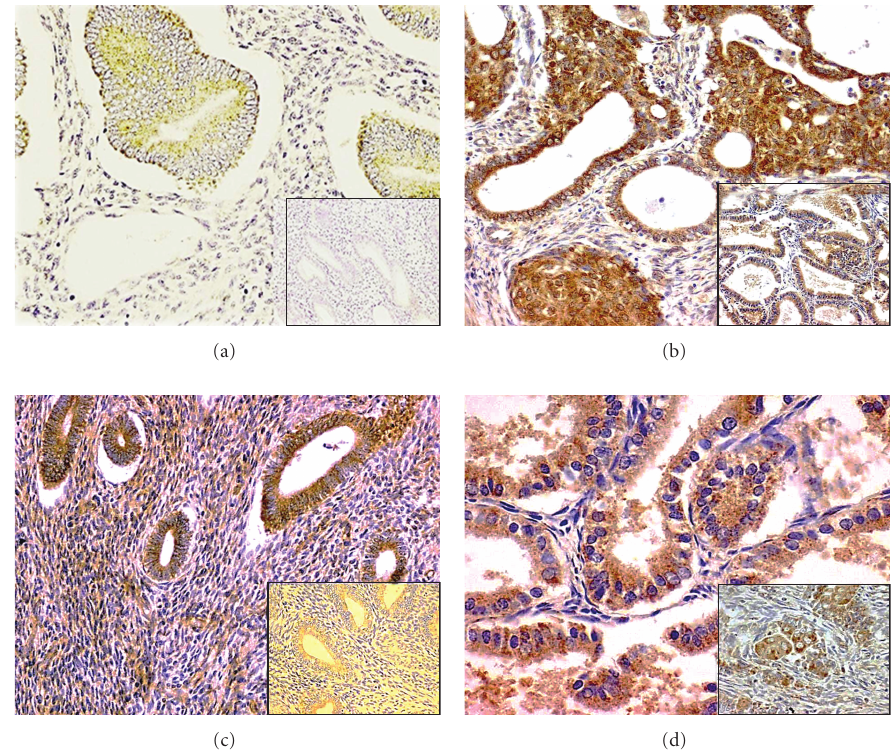
Figure 1: Immunohistochemical expression of PPAR α in normal endometrium (a) and endometrial cancer (b) and PPAR γ in normal endometrium (c) and endometrial cancer (d). Some cells show enhanced accumulation of PPARs in nuclear and perinuclear